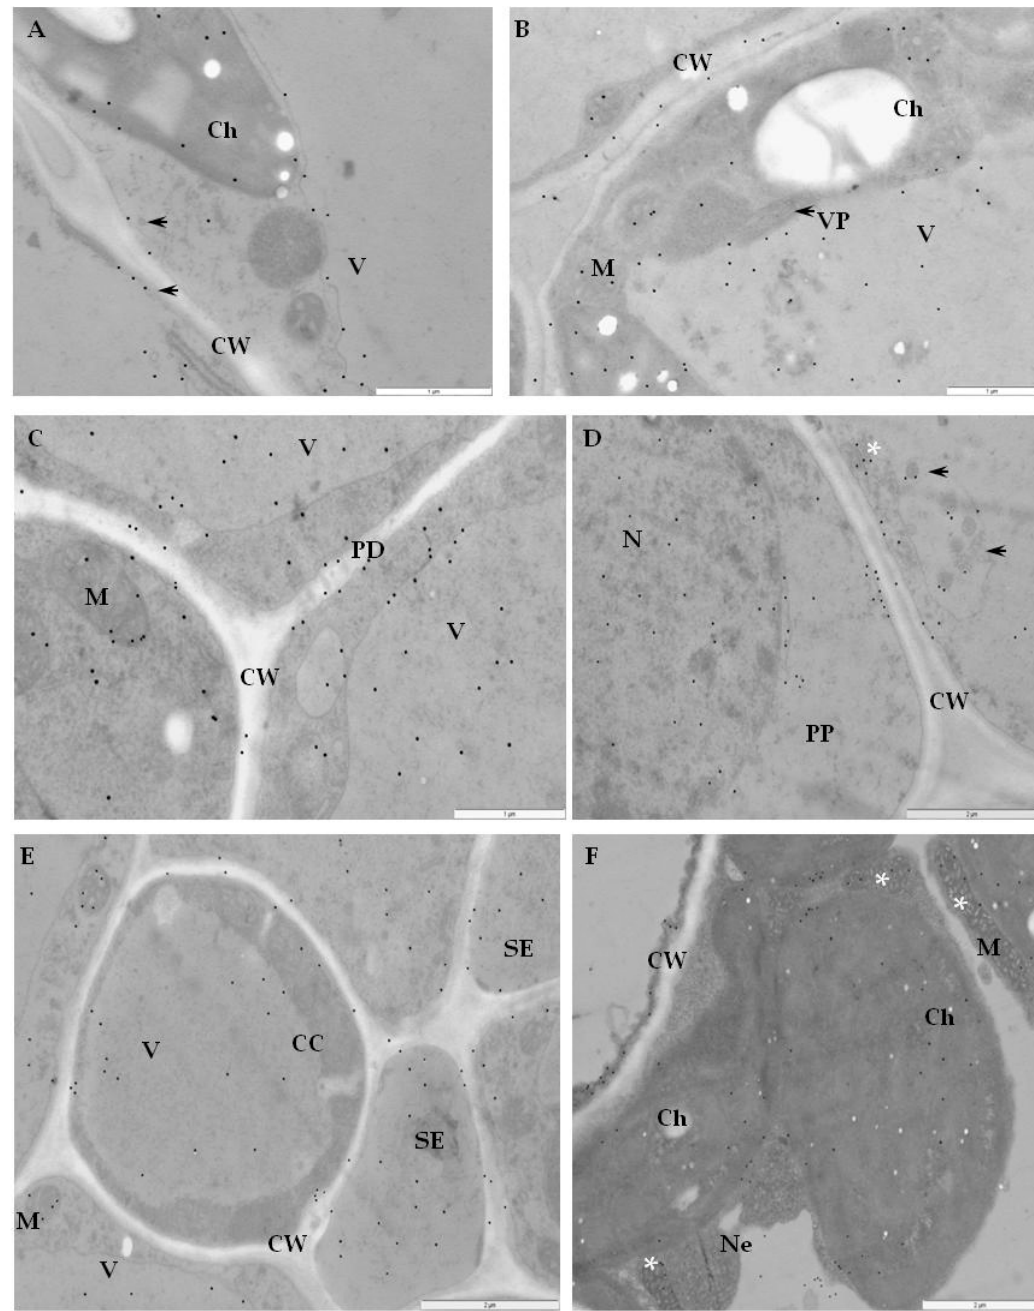
Figure 5. Immunogold labeling of RbohD protein in an incompatible interaction of potato Rywal plants with PVY NTN . ( A ) RbohD antigen gold particles deposition in chloroplast and vacuole of the mesophyll cell. Low deposition of gold particles along the cell wall (arrow) in a mock-inoculated potato Rywal plant. Bar 1 µ m. ( B ) RbohD located in chloroplast and mitochondria 1 day after PVY NTN -inoculation. The deposition in the vacuole and cell wall of the mesophyll cell altogether with virus particles in the cytoplasm. Bar 1 µ m. ( C ) RbohD antigen gold particles in the mitochondria and vacuole in phloem parenchyma cells 1 day after PVY NTN -inoculation. Gold particles present in vesicles and the cell wall around the plasmodesmata. Bar 1 µ m. ( D ) Gold deposition in the nucleus, multivesicular bodies (arrows), phloem cells, and Golgi apparatus (*) 1 dai. Bar 2 µ m ( E ) RbohD deposition in the sieve element, and companion cell 3 days after virus inoculation. Gold particles in the vacuole, mitochondria, and along the cell wall. Bar 2 µ m. ( F ) RbohD detection in necrotizing phloem cells 3 days after PVY NTN -inoculation. Gold particles mainly in the chloroplast with the ultrastructural changes cell wall,